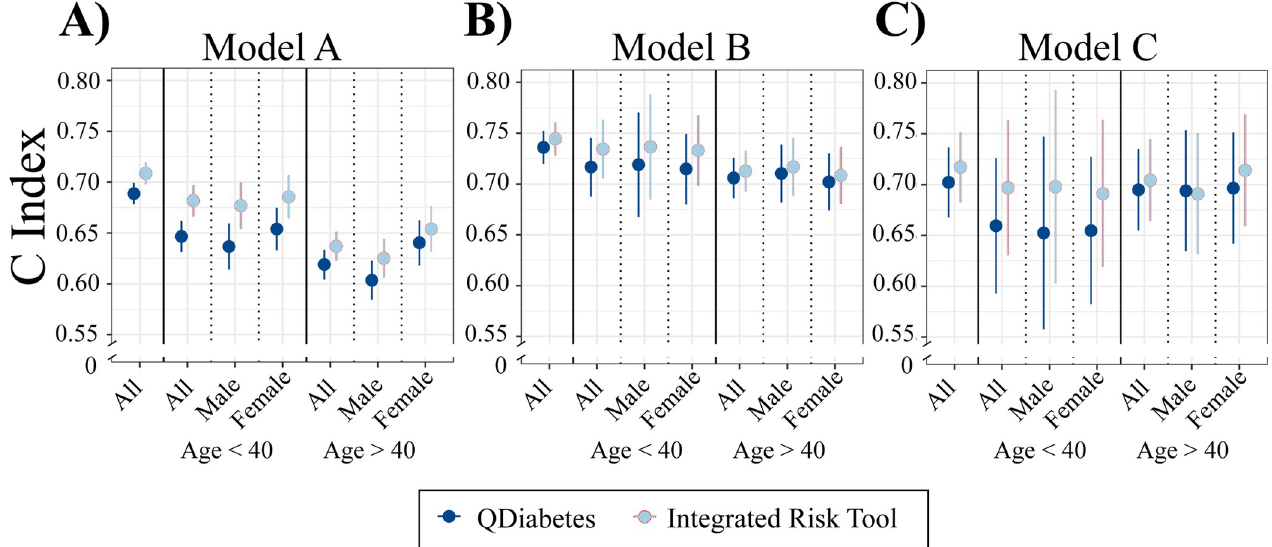
Fig 3. Performance of the IRT using C-Index. Comparison of C-Index calculated from Cox proportional hazard models for QDiabetes models A, B, and C and IRTs combining each QDiabetes model with individual T2D PRS. C-index is presented for all participants and for age-by-sex subgroups. Data are presented as mean with 95% CIs. CI, confidence interval; C-Index, concordance index; IRT, integrated risk tool; PRS, polygenic risk score; T2D, type 2 diabetes.